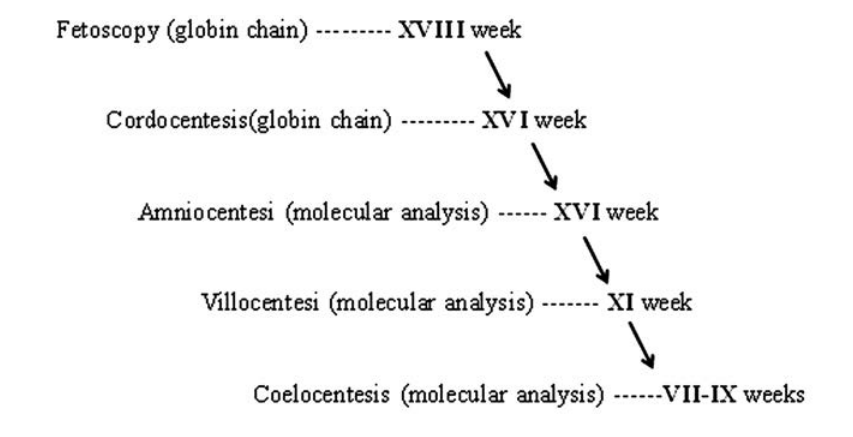
Figure 5. Progress in prenatal diagnosis of